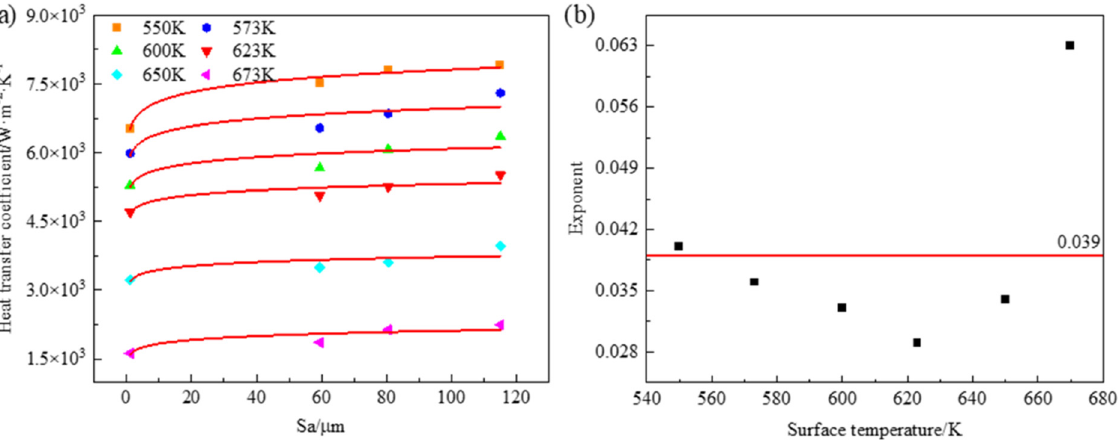
Figure 12. The relationship between HTC and roughness at the impingement zone, including re- gression analysis ( a ) and exponential mean value ( b ).